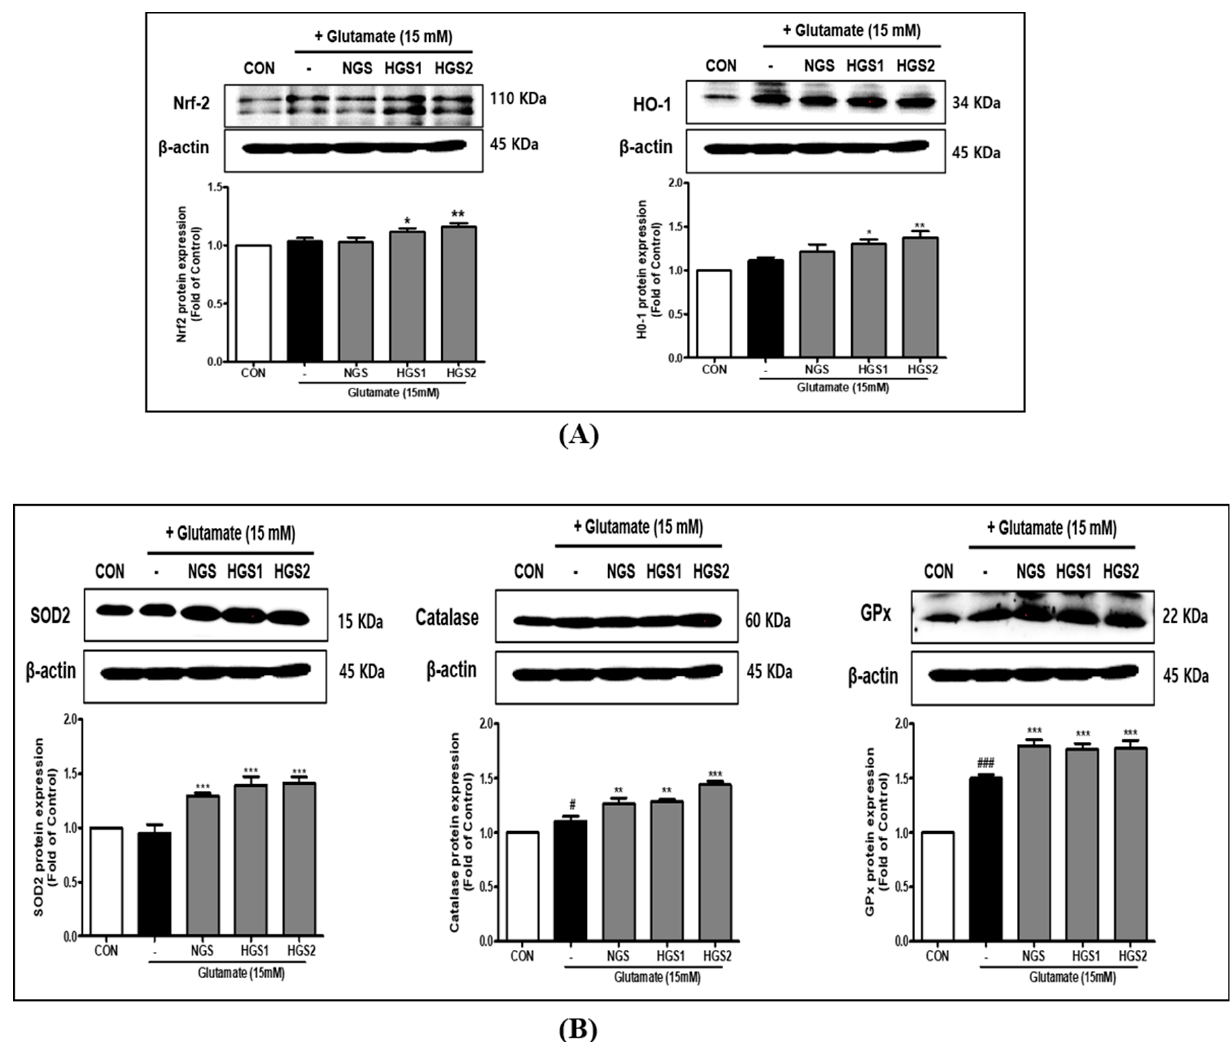
Figure 4. Effect of HGS on the expression of antioxidant enzymes in PC12 cells. Cells were treated with HGS (20 µ g/mL) or the control (0.2% DMSO) for 1 h followed by glutamate (15 mM) for 24 h. Proteins were analyzed by Western blotting using β -actin as the loading control. Nrf2, HO-1, SOD2, CAT, and GPx levels in PC12 cells. Data are means ± standard errors of the mean (SEM). A one-way ANOVA determined significance with Tukey’s post hoc multiple comparison test. # p < 0.1 and ### p < 0.001, significance compared with the control (white bar). * p < 0.1, ** p < 0.01, and *** p < 0.001, significance compared with the glutamate-treated cells (black